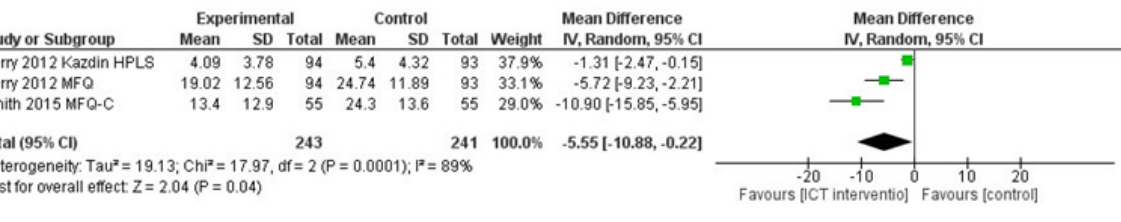
Figure 6. Short-term effectiveness of Web-based interventions on moods and feelings compared with that of a control group.